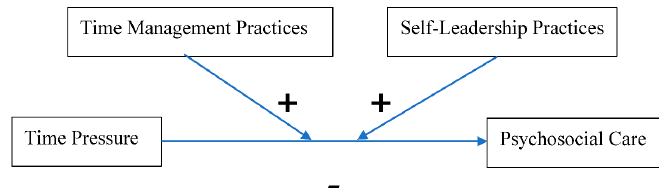
Figure 1. The time pressure mitigation model for nurse managers.